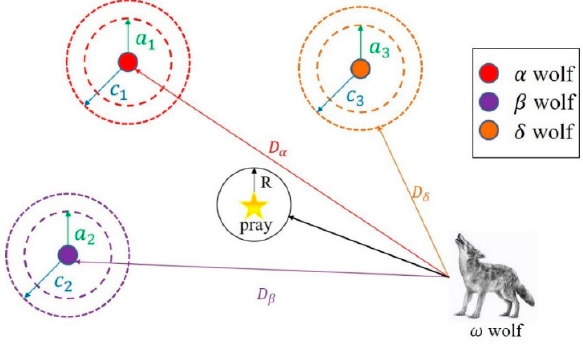
Figure 11. Position update in GWO